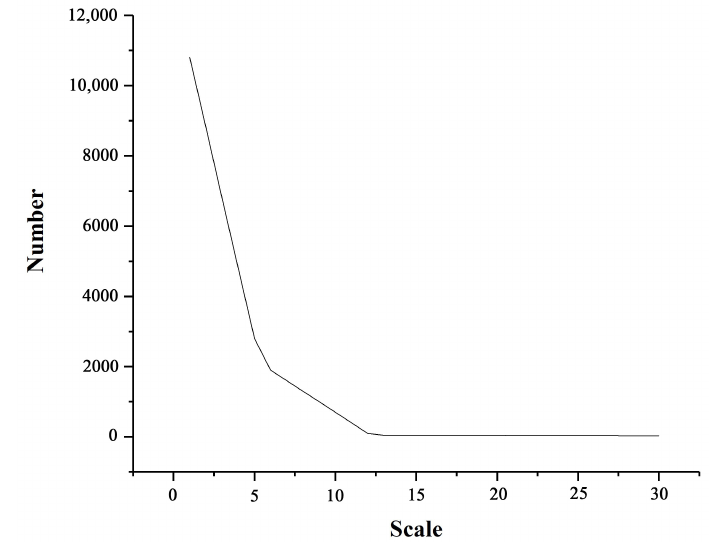
Figure 5. Schematic diagram of the segmentation region in eCongnition changing with scale changes.